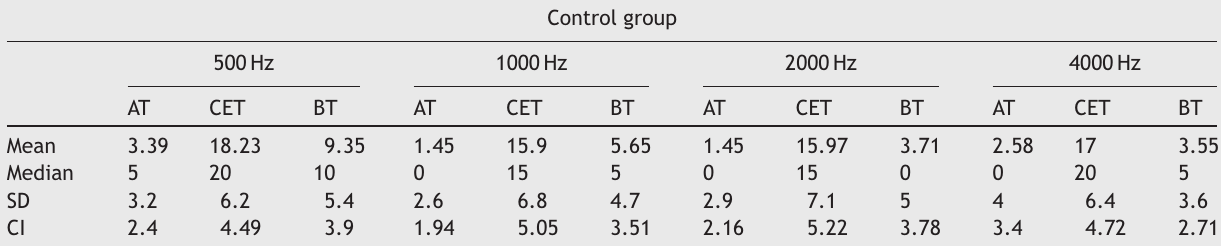
Descriptive measures of auditory, electrophysiological, and behavioral thresholds obtained for control group by